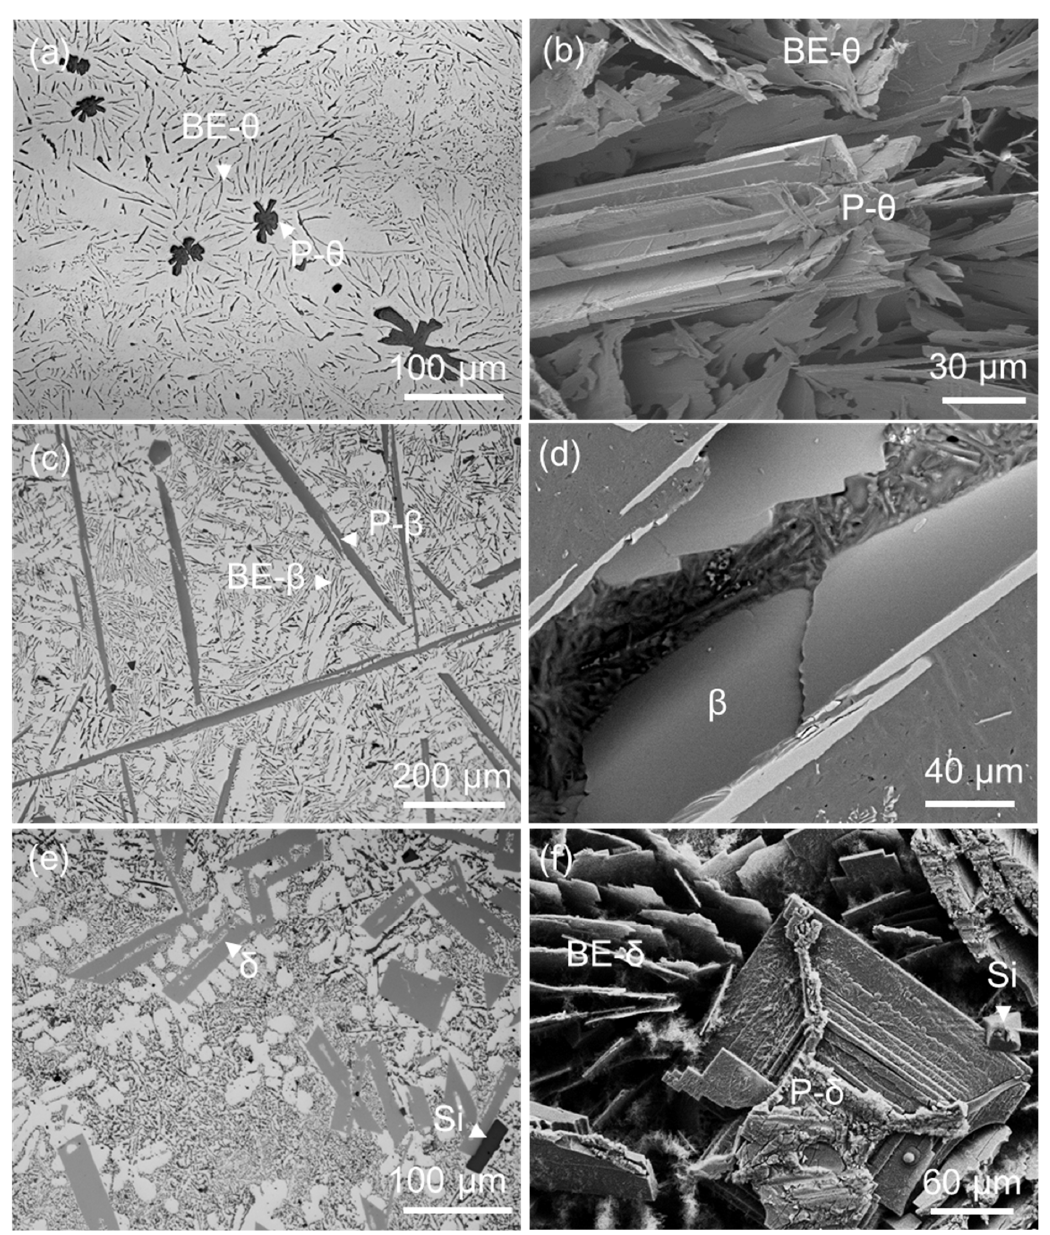
Figure 1. Primary FIMCs have plate ‐ like morphology but with different morphological features. ( a ) optical microscope (OM), and ( b ) SEM ‐ backscatter electron detector (BSD) of the rod ‐ like θ‐ Al 13 Fe 4 in Al ‐ 3Fe alloy with a star ‐ like cross ‐ section [80]; ( c ) OM, and ( d ) SEM ‐ BSD of plate ‐ like β‐ Al 5 FeSi in Al ‐ 12Si ‐ 0.6Mn ‐ 2.8Fe alloy; ( e ) OM, and ( f ) SEM ‐ BSD of short plate δ‐ Al 4 FeSi 2 in Al ‐ 16Si ‐ 3Fe alloy. All alloys were cast at 3.5 K/s. Note: in the figures above, P means primary; BE means binary eutectic.